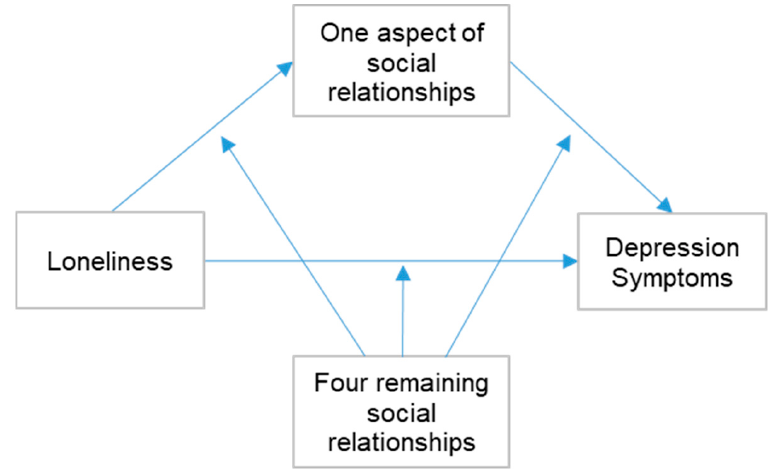
Figure 2. Moderated mediation model with multifaceted social relationships.